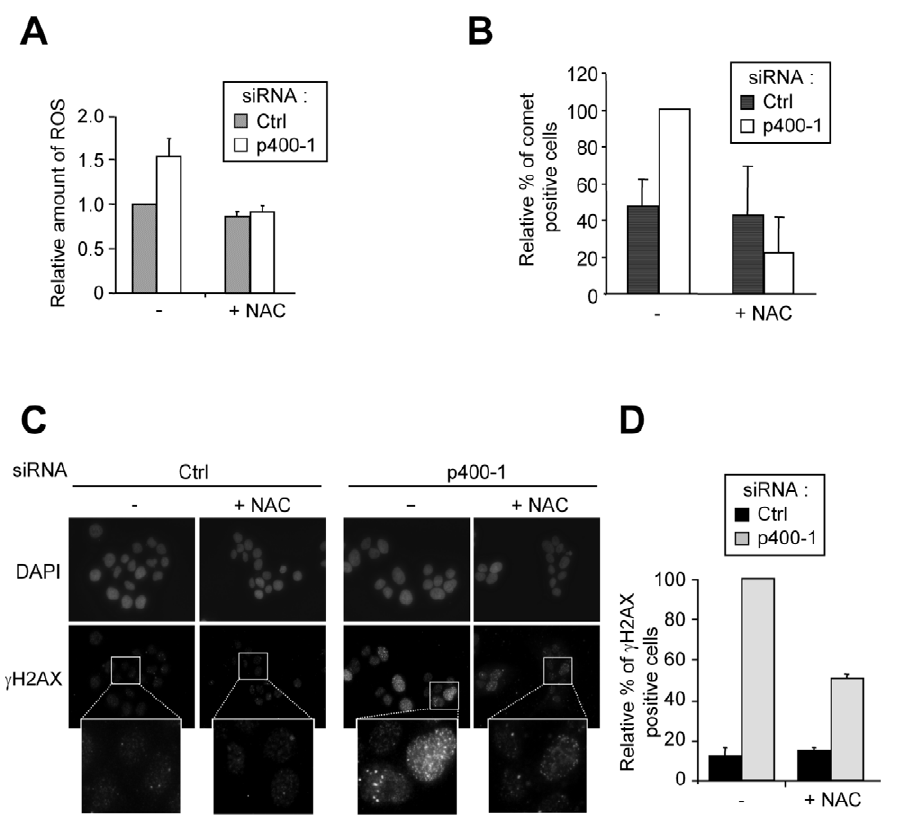
Figure 3. p400 prevents ROS–induced DNA damage. (A) U2OS cells were transfected using the indicated siRNA and treated with NAC (10 mM). 48 h later, cells were collected and ROS levels were measured by flow cytometry. The mean from 2 independent experiments is shown (after standardisation relative to 1 for cells transfected with the control siRNA and untreated). (B) U2OS cells were transfected using the indicated siRNA and treated with NAC (10 mM) 24 h later. 48 h following transfection, cells were subjected to a comet assay. The mean and SD of the proportion of comet-positive cells (tail moment . 5) from three independent experiments are shown (calculated relative to 100 for cells transfected with the p400-1 siRNA and not treated). (C,D) Same as in (A) except that cells were fixed and subjected to DAPI staining and an immunofluorescence analysis using anti- c H2AX antibodies. Representative fields are shown in (C) and quantification using ImageJ software is shown in (D) (mean and SD from 3 independent experiments are shown (after standardisation relative to 100 for cells transfected with the p400 siRNA and untreated)).